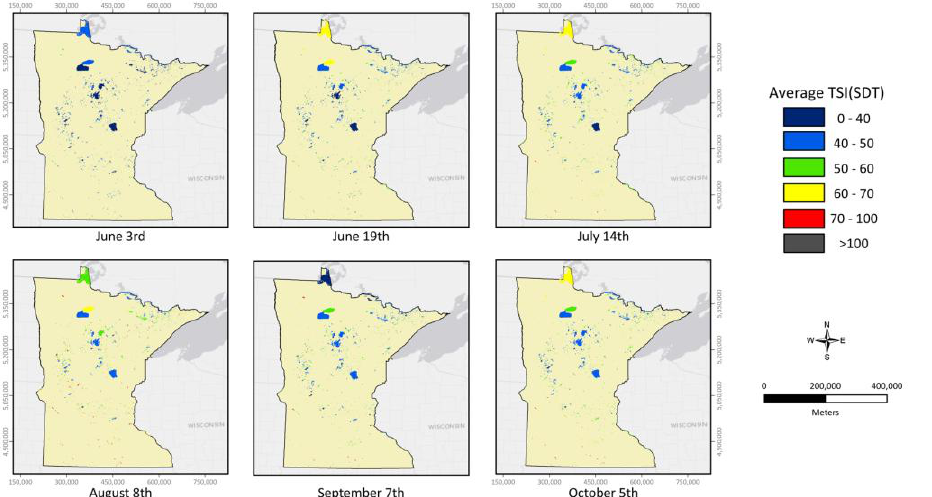
, averaged from the water pixels in each (SDT)